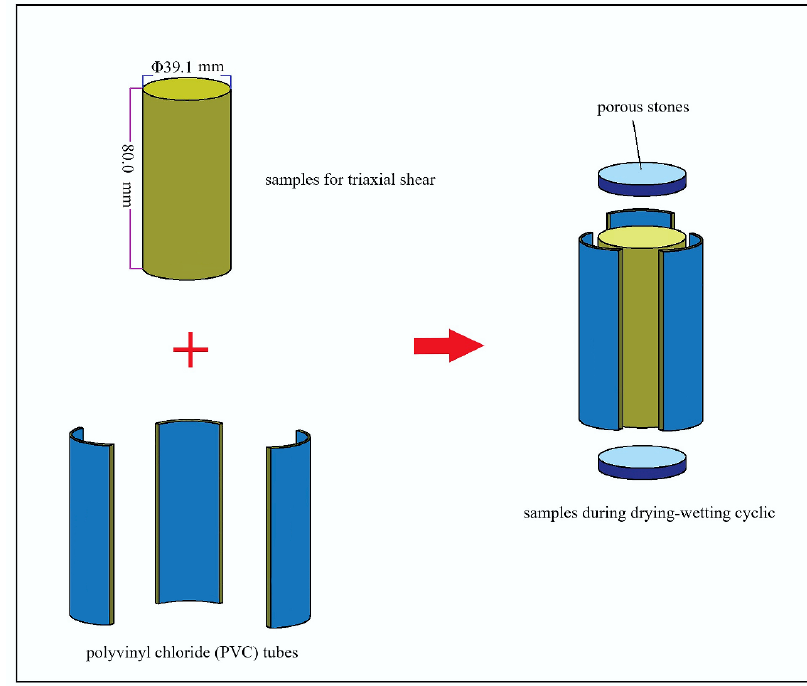
Figure 4. Illustration of usage of PVC pipe during drying–wetting cyclic process.